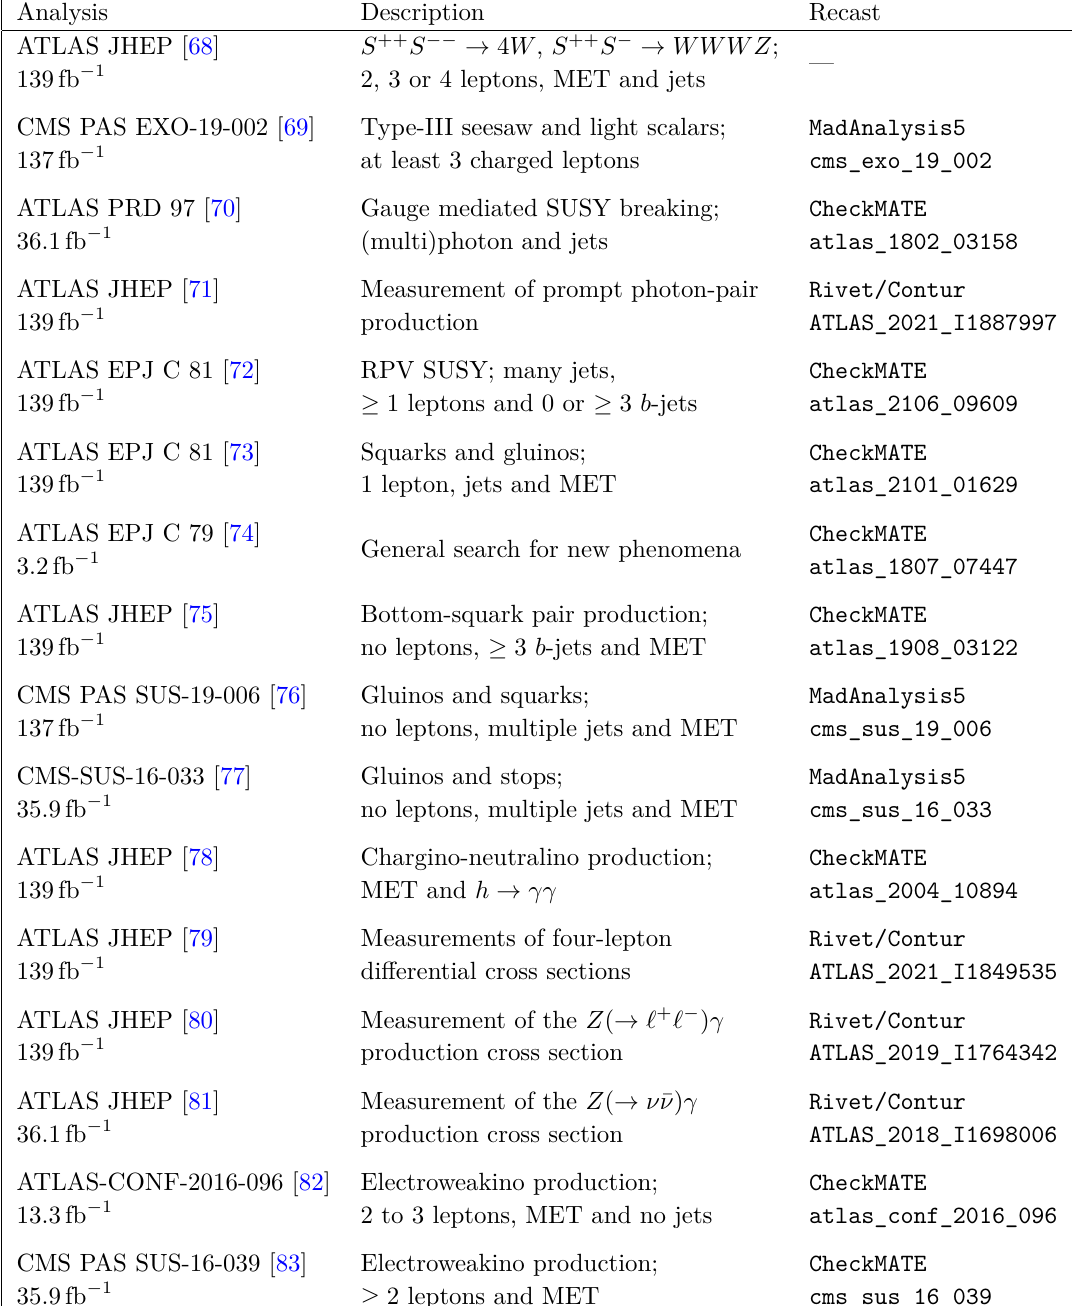
Table 3. Summary of the analyses that contribute to the simplified model bounds in figure 2.